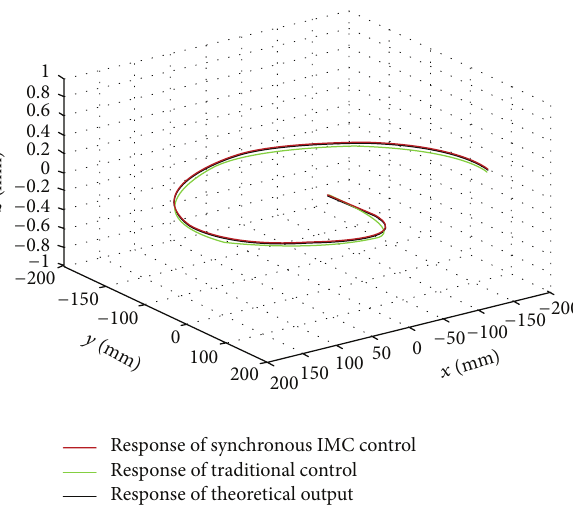
Figure 7: 3D comparison chart of output response.